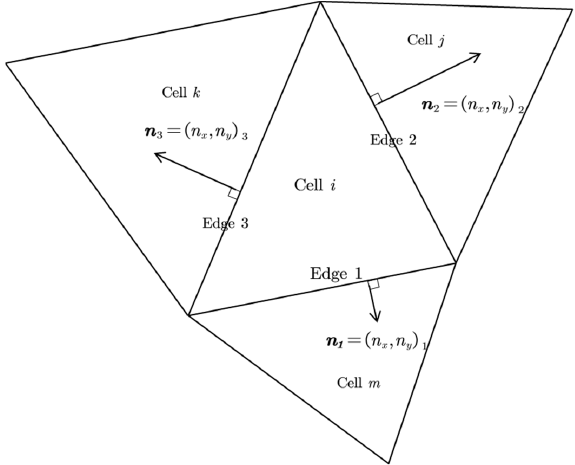
Figure 1. The cell topology of unstructured grids.